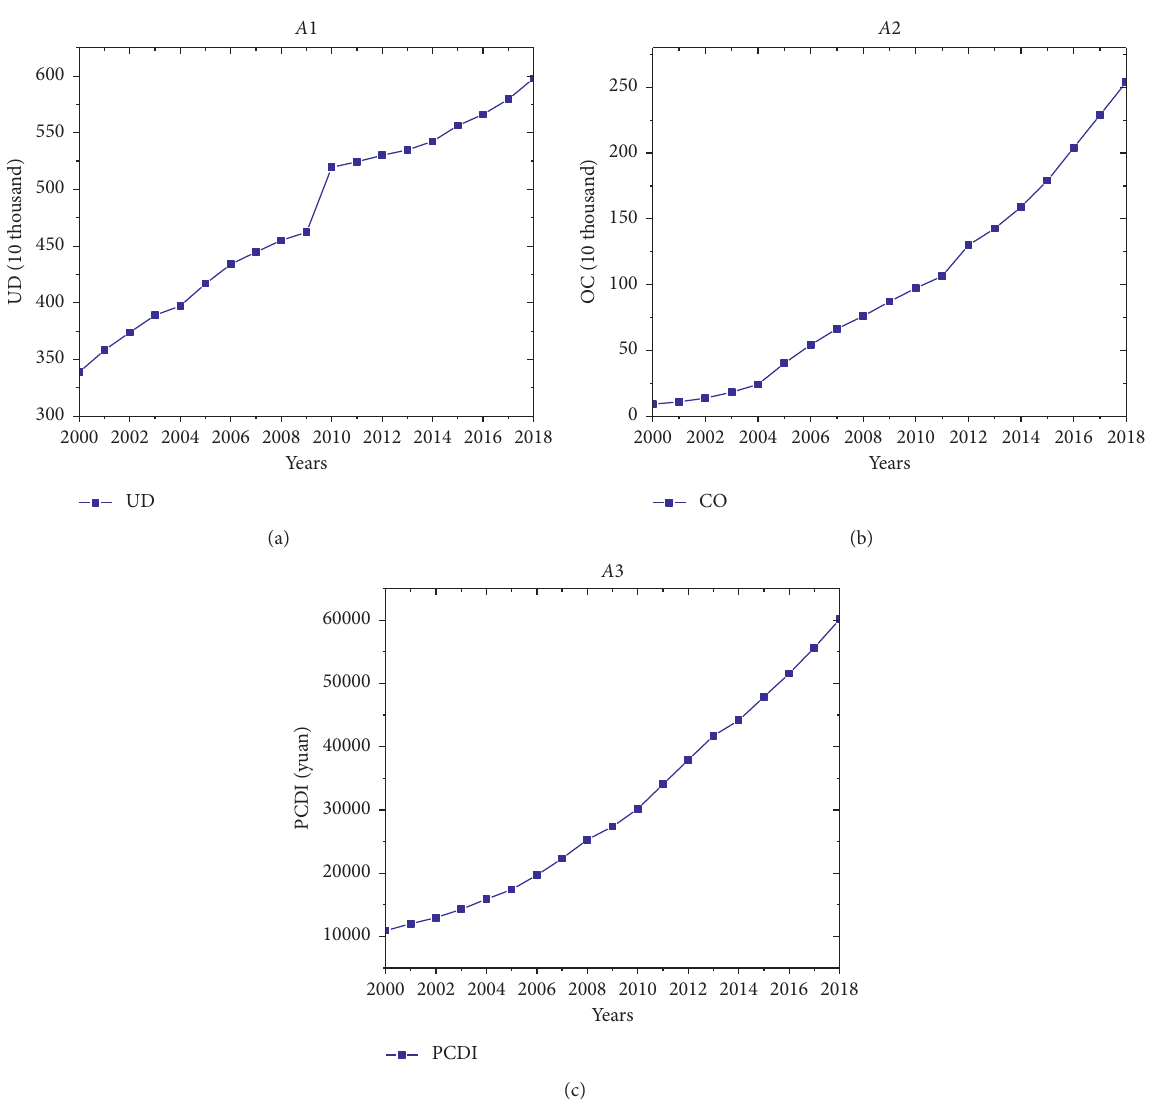
Figure 4: Changes in the three data series for Ningbo from 2000 to 2018: (a) changes in the UD historical data, (b) changes in the CO historical data, and (c) changes in the PCDI historical